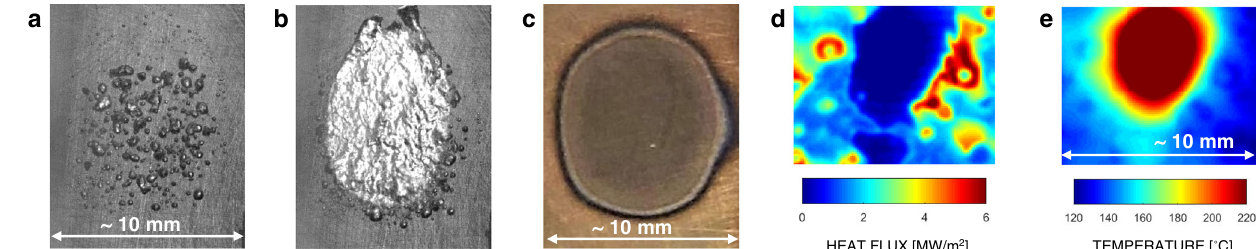
Fig.1|Theboilingcrisis.a High-speedvideoimageofthenucleateboilingprocess. b High-speed video image of the fi lm boiling process (on the same surface as a ). a and b show examples obtained in fl ow boiling conditions on a vertical surface. c Picture of a burnt-out surface which experienced the boiling crisis. This burnout maybefollowedbythemelting of the surface. d Heat fl uxdistributionon